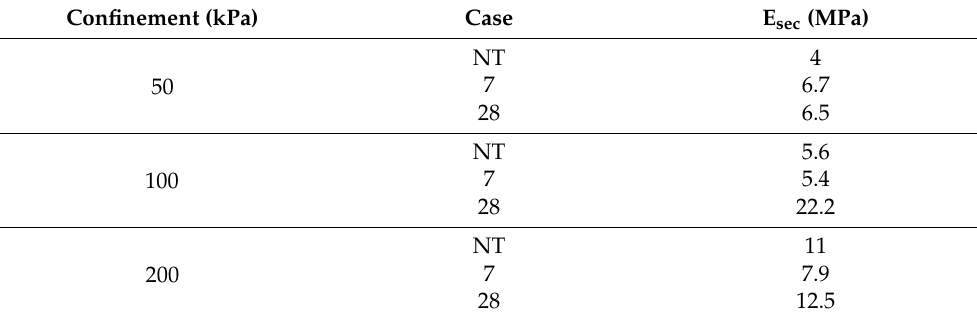
Figure 9. Triaxial for Maicillo treated with CMICP.